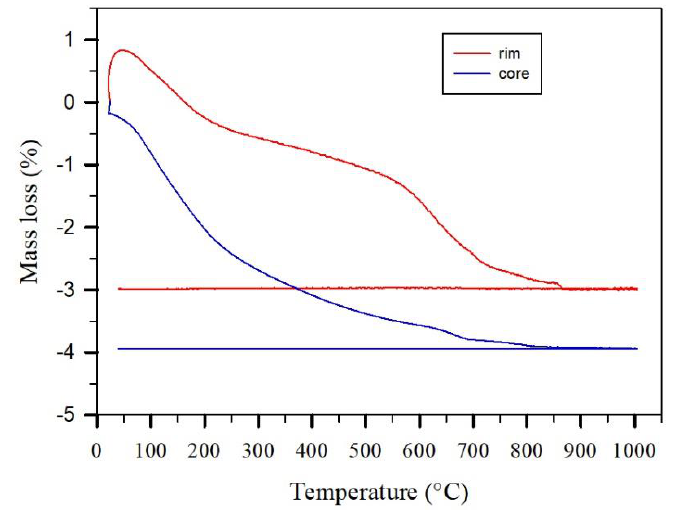
Figure 4. Mass loss during heating of a fresh lime sand brick probed at the core and the rim.